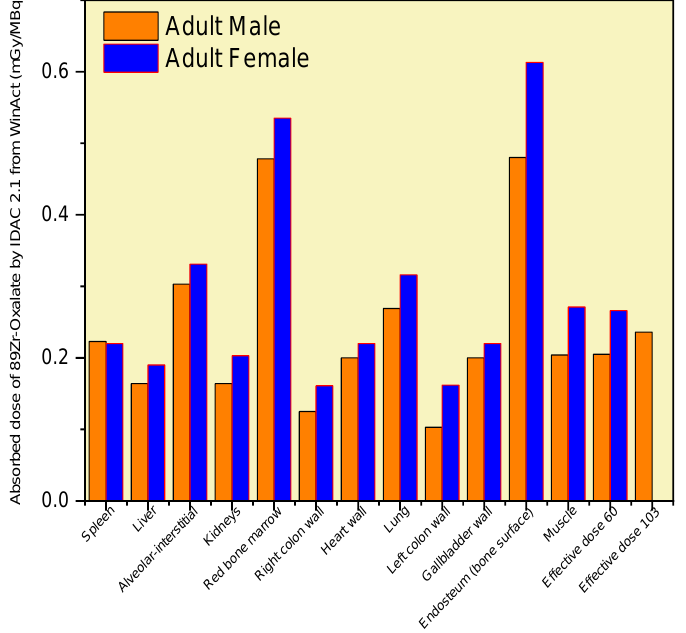
Figure 6. 89 Zr-oxalate absorbed dose in mGy/MBq over time for certain organs, calculated by the IDAC-2.1-software using input data from the WinAct program. Table 5. Estimation of absorbed dose of 89 Zr-oxalate in various organs using IDAC 2.1 and WinAct, measured in mGy/MBq.